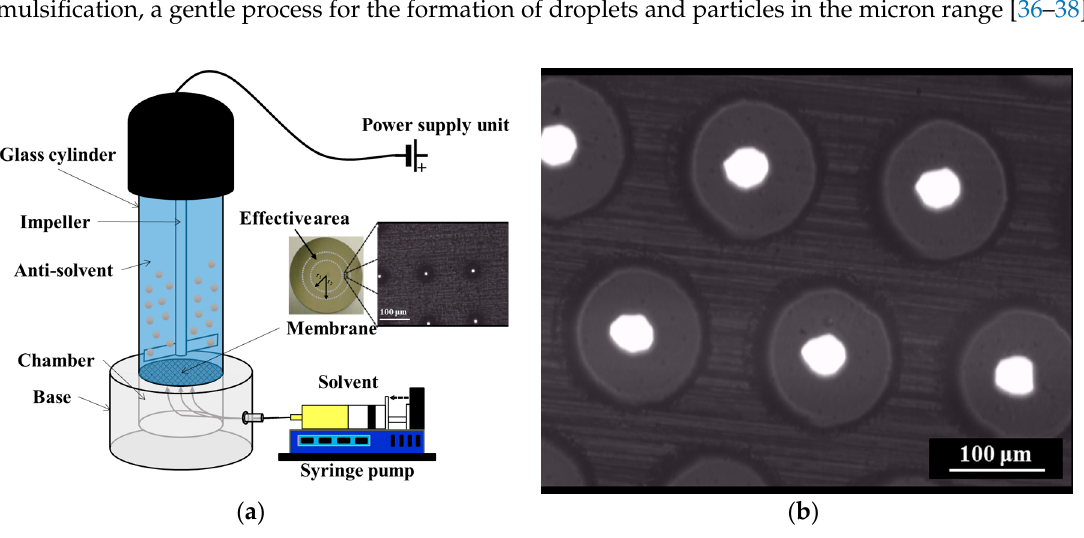
Figure 2. ( a ) Schematic of the rig used for membrane crystallization; ( b ) Scanning electron microscope (SEM) image of the Ni membrane used for the experiments.